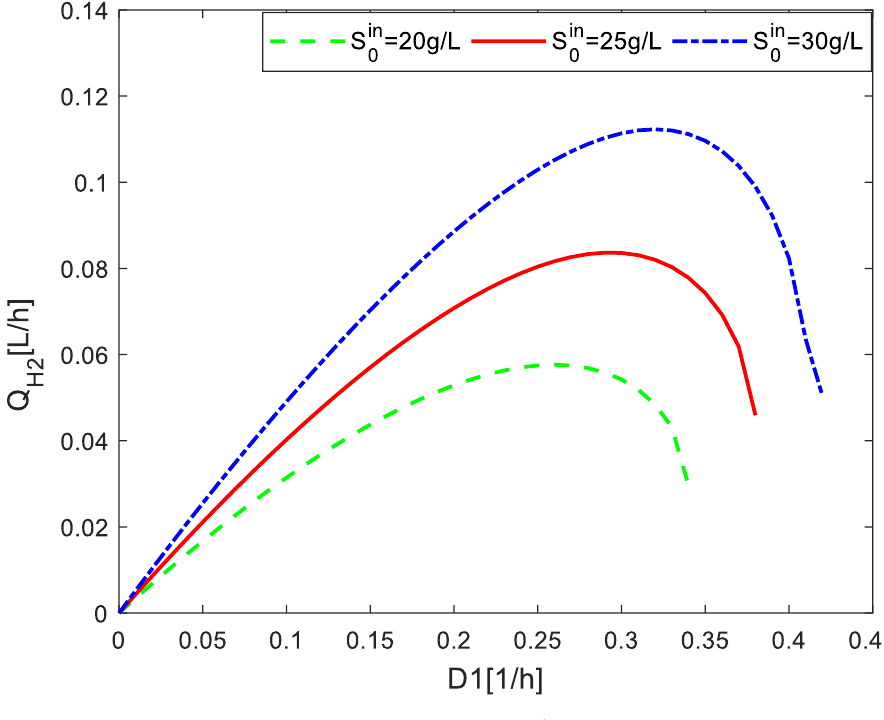
DQ for different - for different S in H 2 2 1